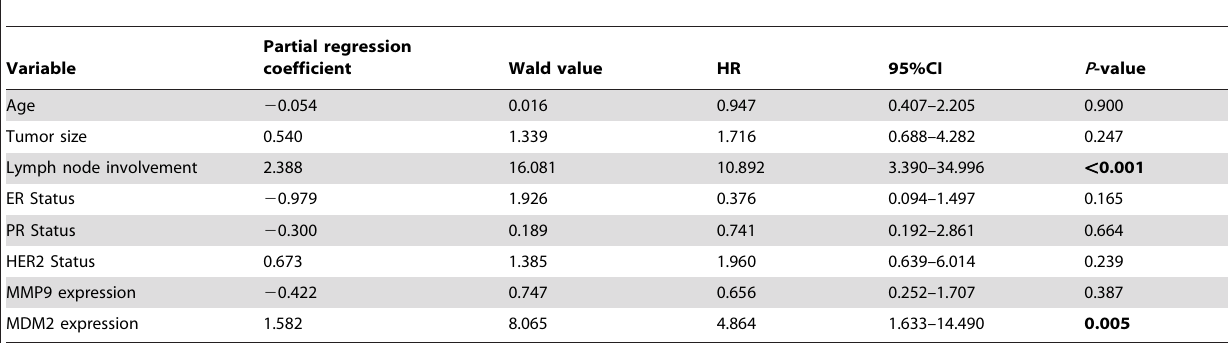
Table 3. Multivariate analysis using the stepwise backward elimination method in patients with IDC.